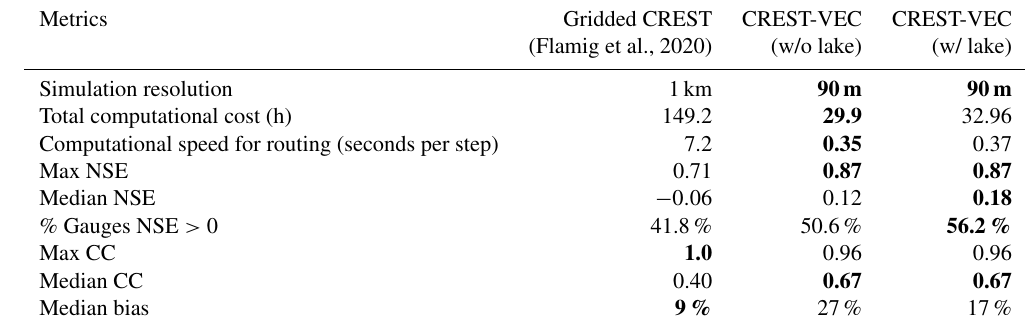
Table 1. Statistical comparison of model performance over the continental US. Bold numbers indicate the best metrics among the three model configurations. The computational speed is calculated as an average speed over a whole simulation period.